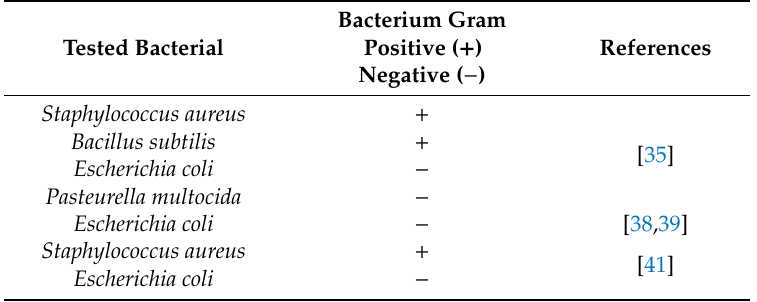
Table 1. Antibacterial activity of discussed polyurethane / chitosan composites.